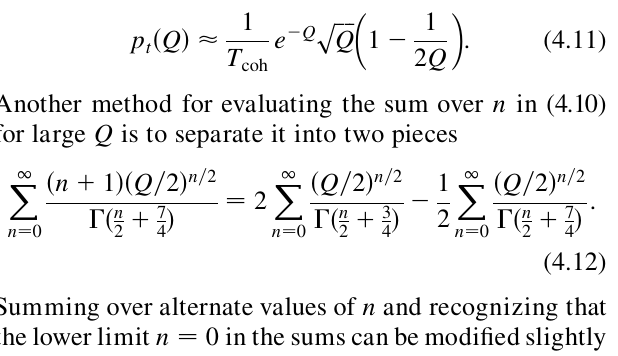
(cid:1) ~ QQ (cid:2) =N d ~ QQ is the probability of a peak in the FIG. 4. p ! ! frequency domain having normalized intensity between ~ QQ and ~ QQ (cid:12) d ~ QQ (dimensionless